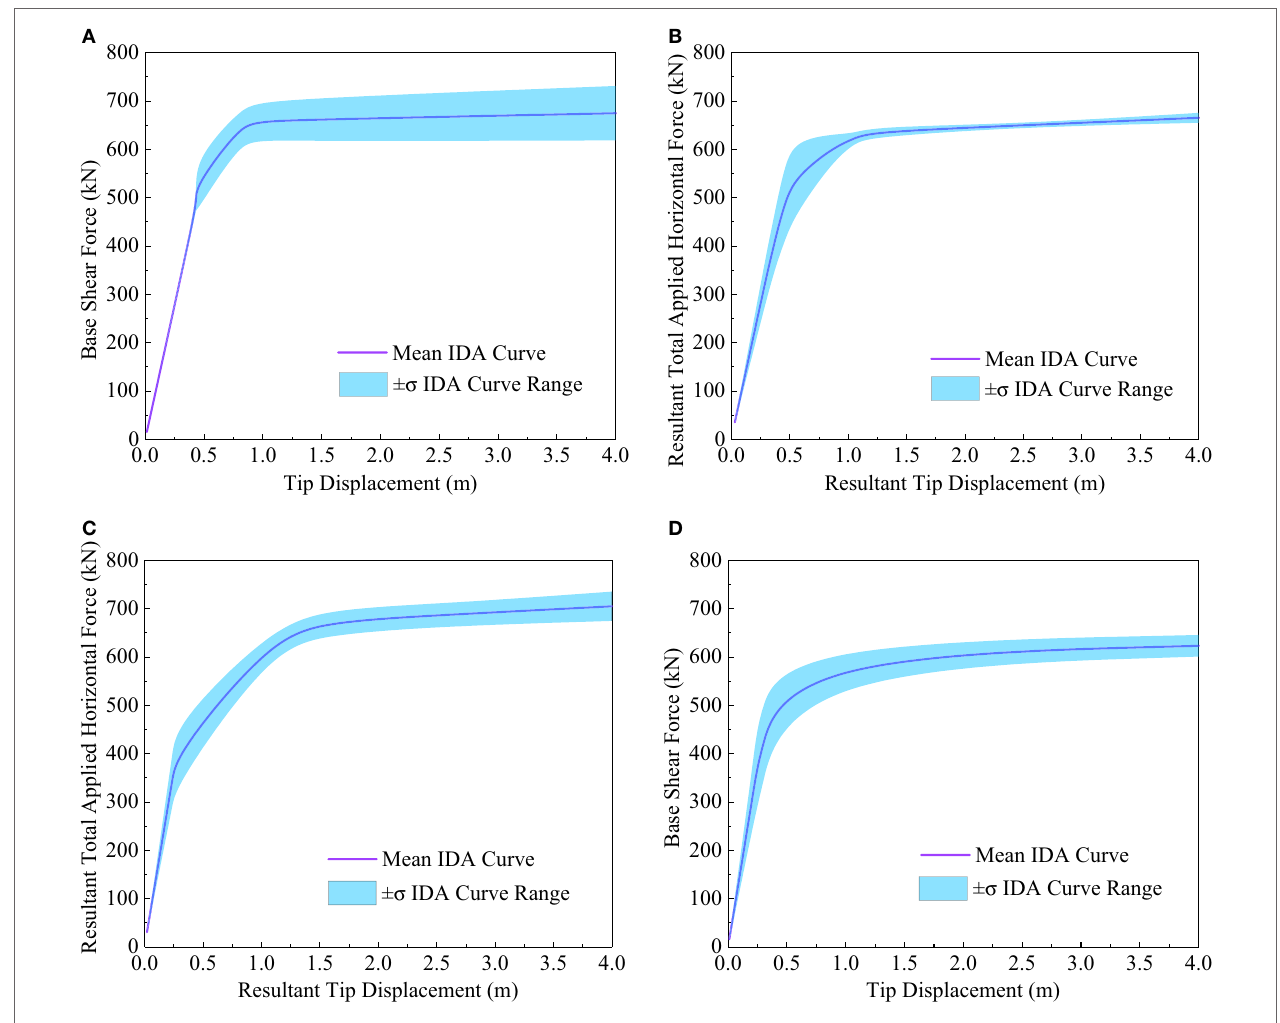
FigUre 14 | capacity curve with 68% confidence level ( ±σ ) . (a) β = 0°. (B) β = 30°. (c) β = 60°. (D) β =